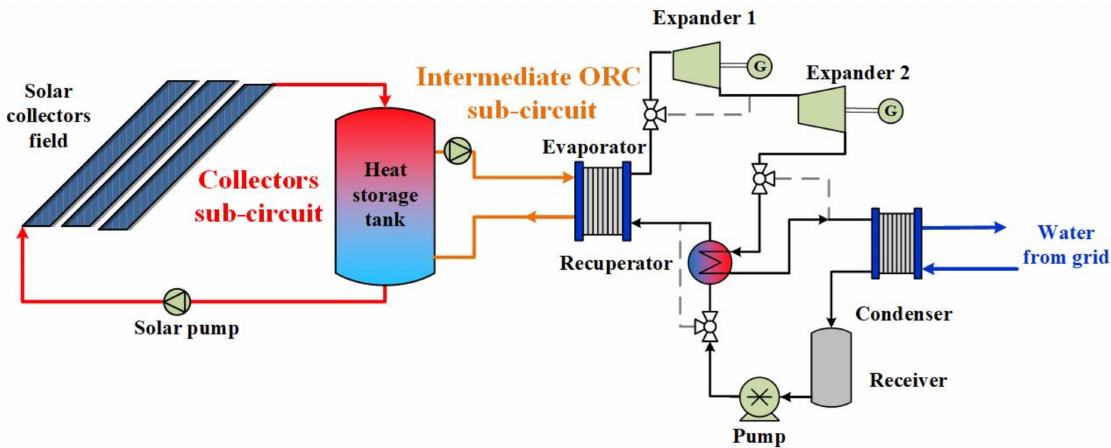
Figure 1. Layout of the investigated solar-driven ORC with a recuperator and two serial